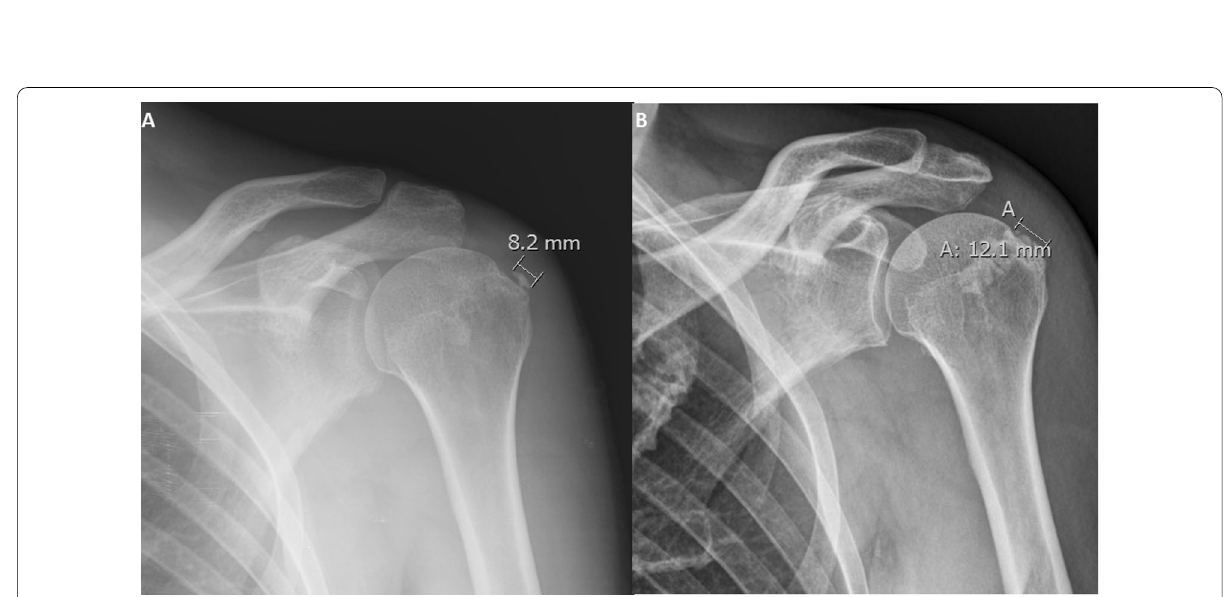
Fig. 4 Anteroposterior shoulder x-ray performed at baseline ( A ) and after 10 years ( B ) shows the increased size of the